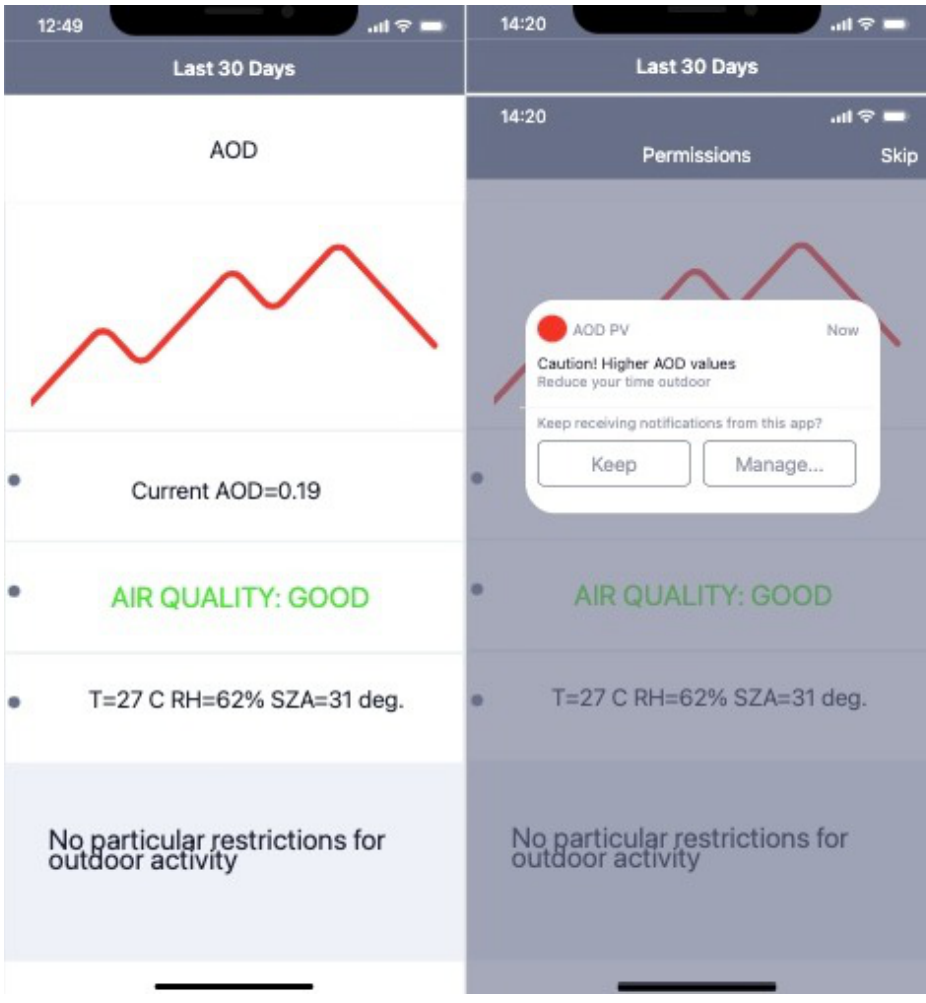
Figure 7. Left : A possible Graphic User Interface for iPhone users. The app will show the plot relative to the last 30 days of measurements. The lower panel shows the current AOD value and good air quality. Right : Example of notification alerting app users about pollution above a certain threshold. The notification also suggests to limit time spent outdoors. The notifications, based on AOD levels, will notify users with different kinds of